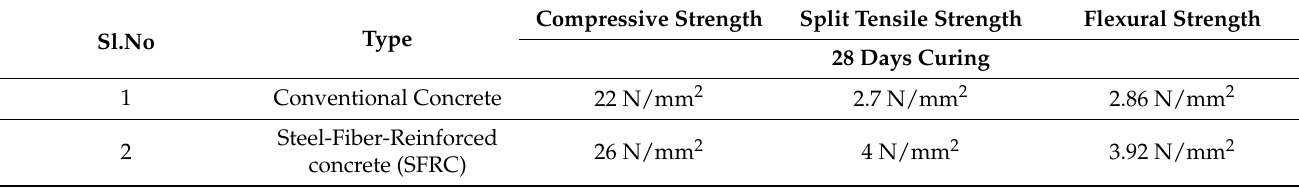
Table 5. Mechanical properties of concrete.